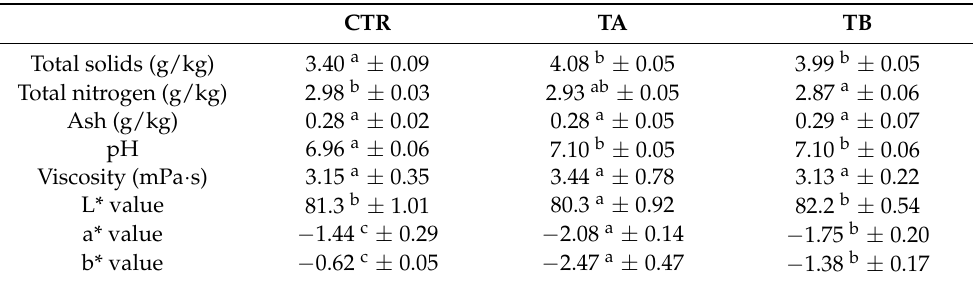
Table 1. Composition, physicochemical and colour attributes of mTG crosslinked micellar casein concentrate feed used in